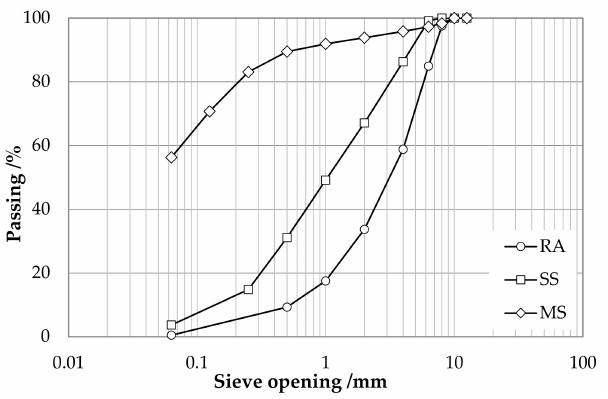
Figure 1. Particle size distribution of reclaimed asphalt (RA), sand (SS) and mineral sludge (MS). Table 1. Apparent density of reclaimed asphalt (RA), sand (SS) and mineral sludge (MS). Fractions